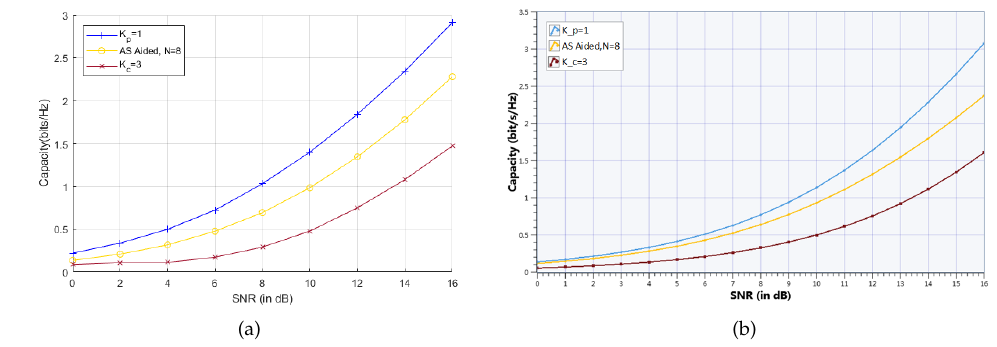
Figure 10. Achievable capacity performance comparison of proposed UOSTxAS in case of K P = 1, K C = 3 and AS aided MU-MIMO systems associated with K = 2 active users, N T = 4 transmit RF chains. ( a ) Simulation result from MATLAB. ( b ) Measurement result from NI SDR